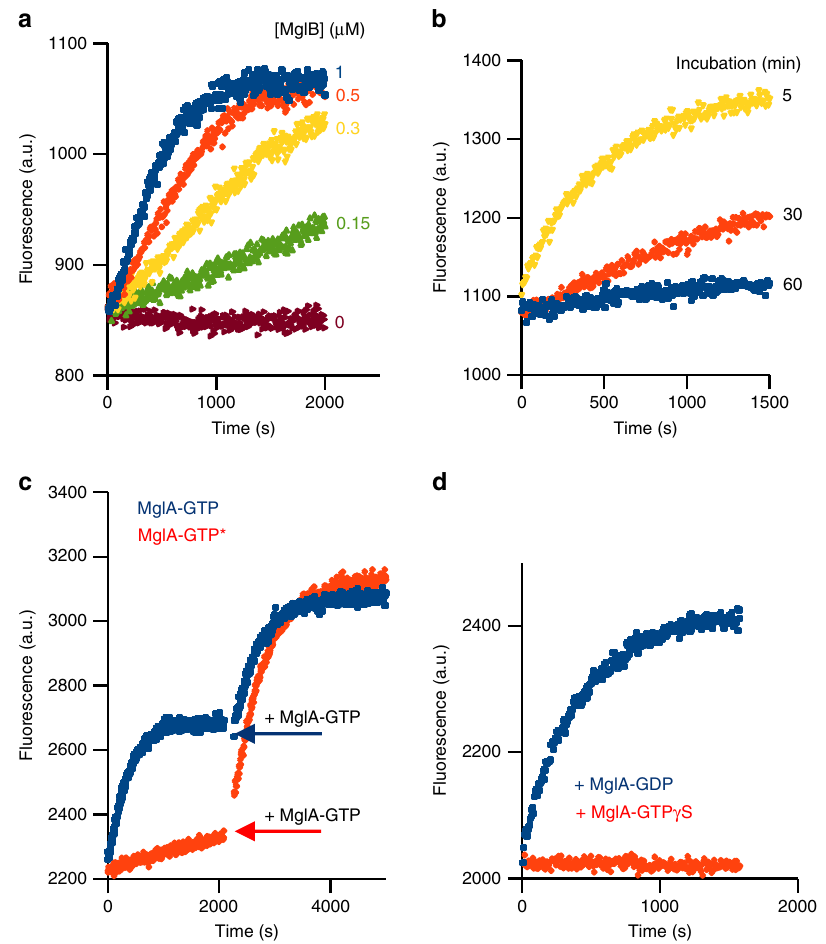
Fig. 3 Inactivation of MglA by MglB is regulated by a positive feedback loop. a Kinetics of GTP hydrolysis stimulated by MglB. Kinetics were monitored by fl uorescence using a reagentless phosphate-binding assay at a fi xed MglA concentration (1 µ M) and increasing concentrations of MglB as indicated. b Time-dependent desensitization of MglA to MglB-stimulated GTP hydrolysis. MglA-GTP was incubated at 25 °C for increasing periods of time as indicated, before GTP hydrolysis was initiated by addition of MglB. c Desensitization of MglA from MglB is reversed by addition of MglB-sensitive MglA-GTP. MglB was added to MglB-insensitive (in orange) or MglB-sensitive (in blue) MglA-GTP and GTP hydrolysis was monitored for the duration needed for the MglB- sensitive sample to reach the plateau. Then, the same amount of MglB-sensitive MglA-GTP was added to both samples (arrow). Note that both kinetics curves reach the same plateau, indicating that all MglA-GTP has been converted to MglA-GDP in all experiments. d MglA-GDP, but not MglA-GTP γ S,